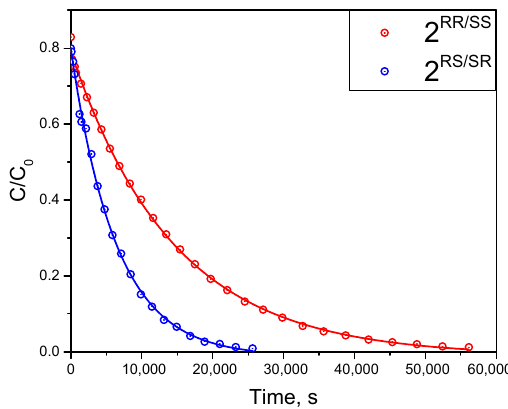
Figure 8. Kinetic curves of alkoxyamines decomposition of 2 RS / SR and 2 RR / SS at 347 K in toluene-d 8 in the presence of spin trap PhSH.